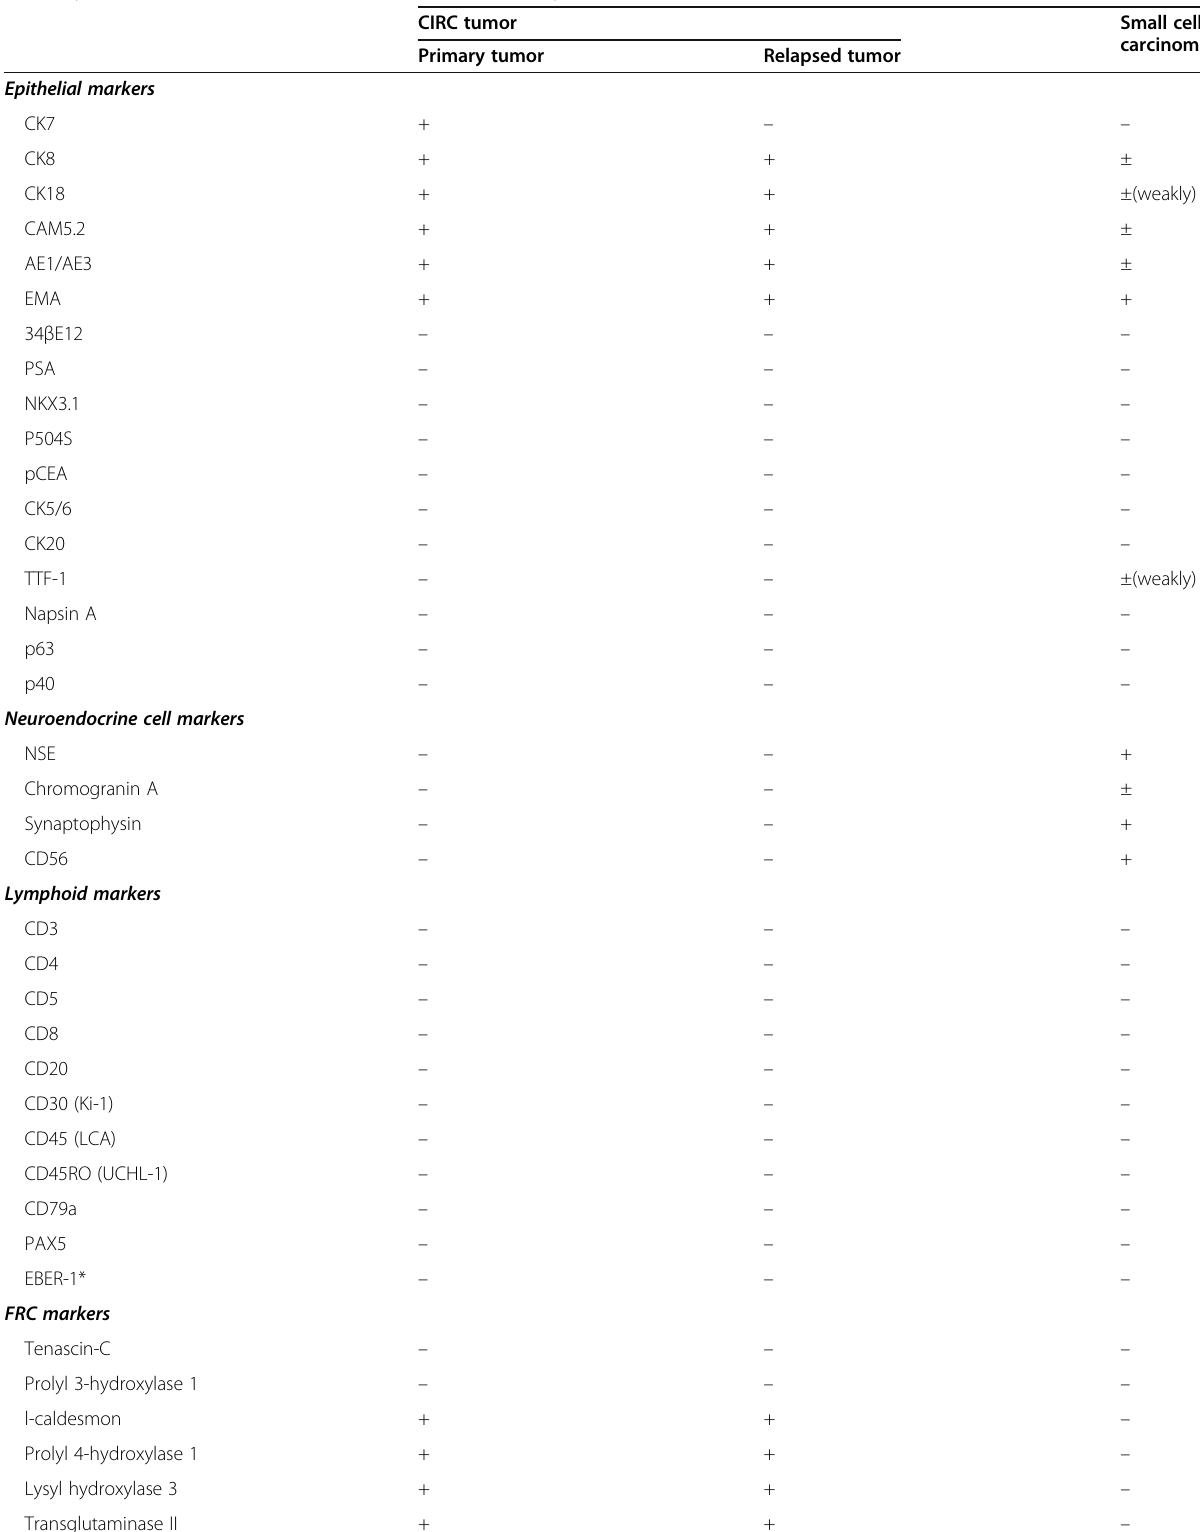
Table 1 Immunophenotypes of CIRC tumor and small cell carcinoma of this case